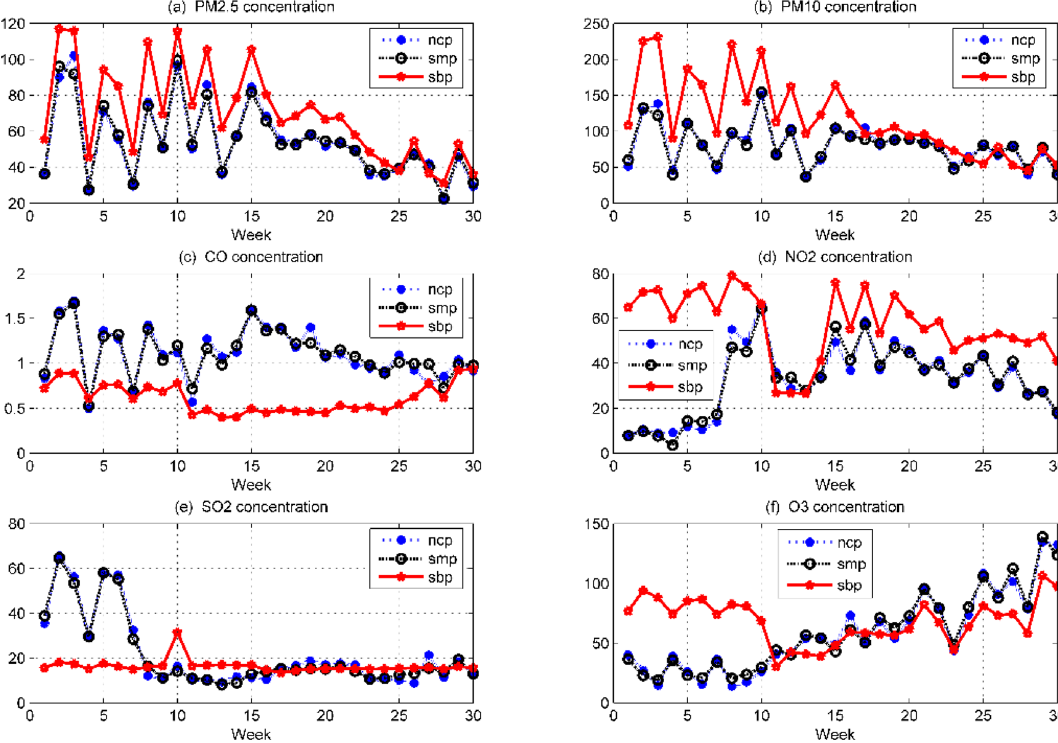
Figure 7. Comparison of weekly average data of six types of pollutants at national control points, self-built points and SRM-MLP model correction